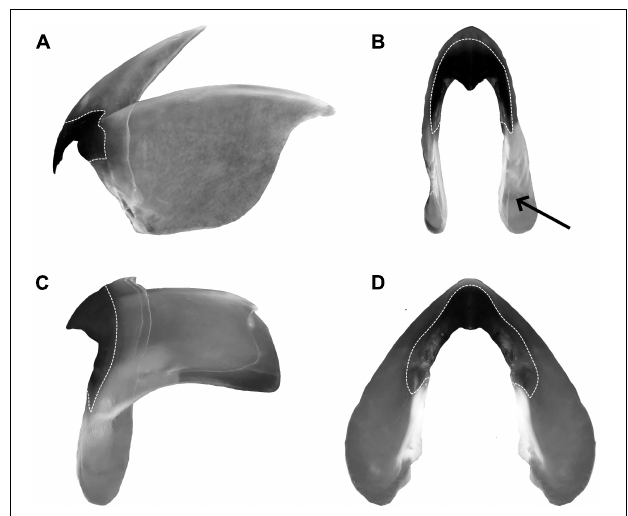
FIGURE 6 | Beak extracted from Sepioteuthis lessoniana . (A) Upper beak, lateral face; (B) upper beak, frontal face; (C) lower beak, lateral face; (D) lower beak, frontal face. Dotted lines represent the pigmented parts of the beak, arrow points to a section of the wing which is deformed due to